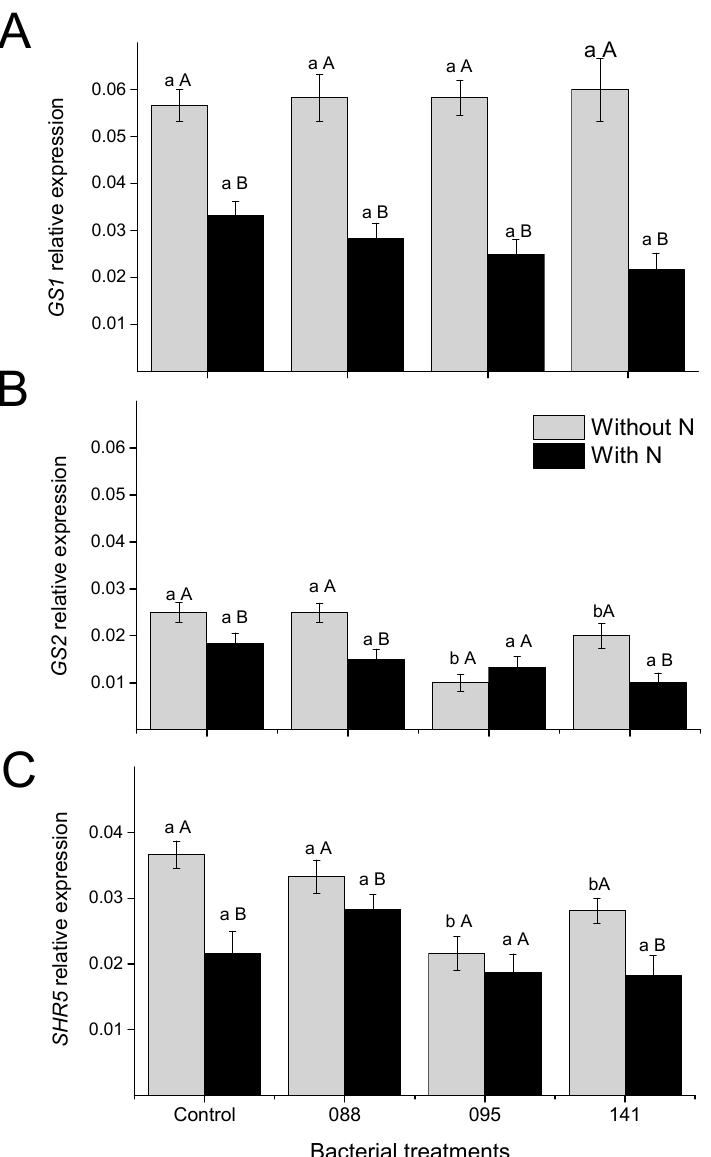
Figure 2. Relative expression levels of the genes GS1 ( A ), GS2 ( B ), and SRH5 ( C ), in leaves of sugarcane seedlings inoculated or not (Control) with IAC-BECa-088, IAC-BECa-095, and IAC-BECa-141 = IAC/BECa-141 bacterial strains, and normalized by the expression of GAPDH reference gene transcript levels and with (black bars) or without (gray bars) nitrogen fertilizer, 45 days after transplanting. Different lower-case letters (a,b) indicate significant differences among bacterial treatments within each N fertilization treatment, and capital letters (A, B) indicate significant difference between N fertilization treatments within each bacterial treatment by the Scott-Knott test ( p < 0.05).